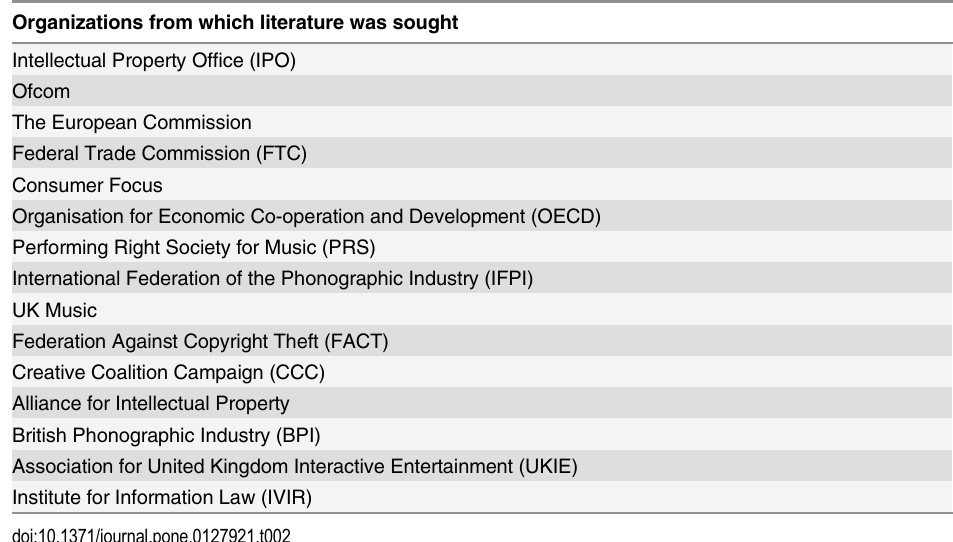
Table 2. Attempted sources of grey literature.